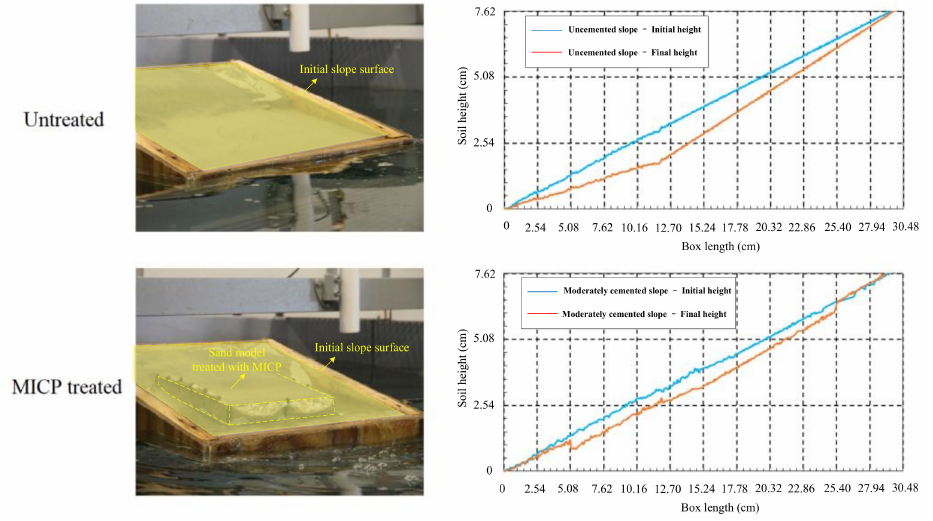
Figure 7. Erosion resistance of sandy slope treated by MICP (Modified from [53]).